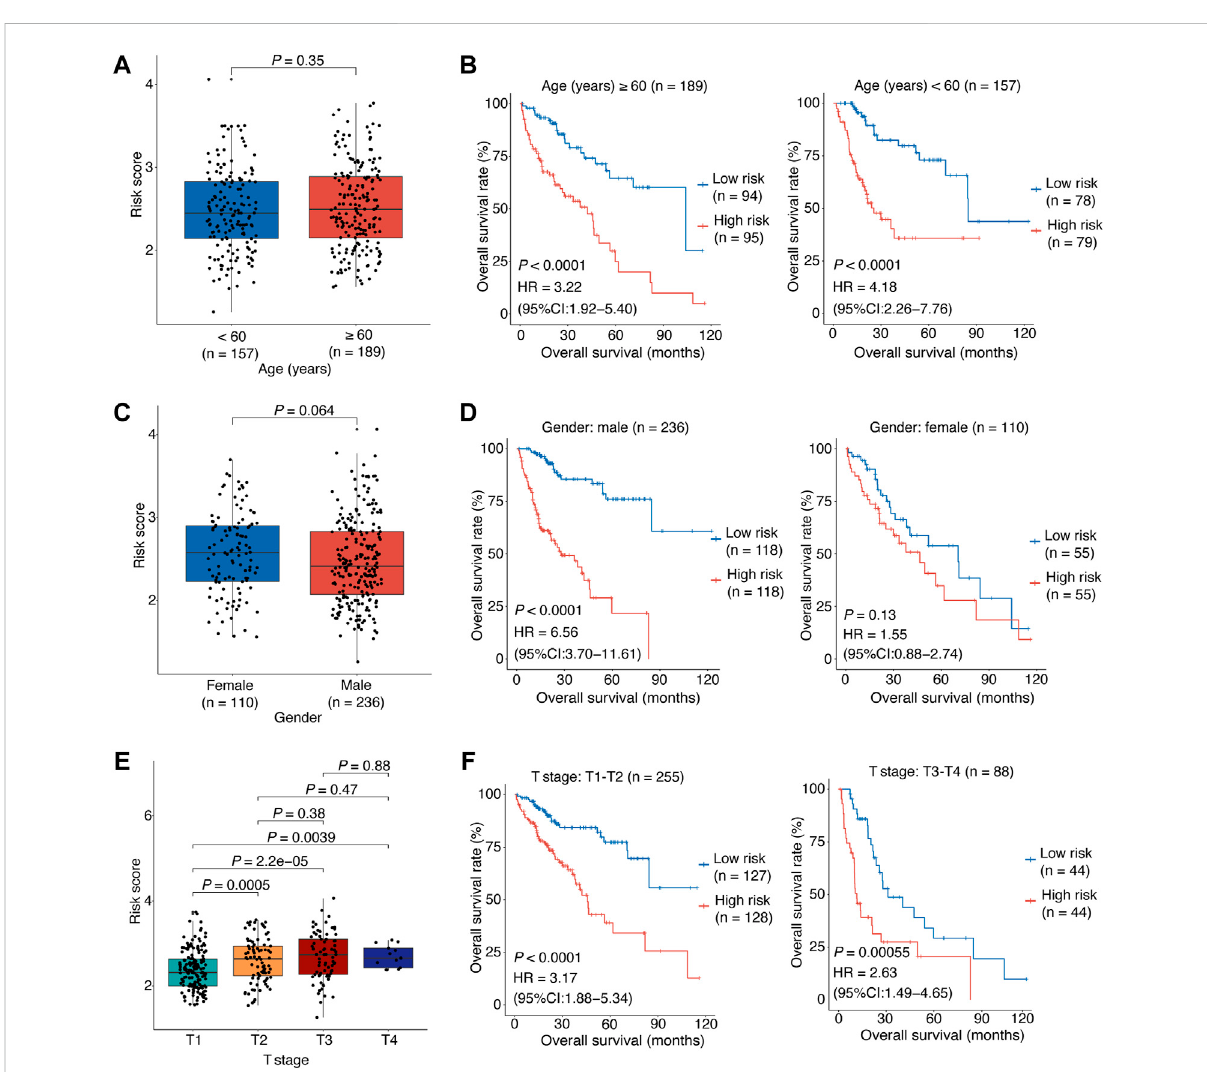
FIGURE 4 Strati fi ed analyses of association between the risk score and HCC overall survival. (A) The correlation between the risk score and the patient ’ s age. (B) The risk score ’ s predictive value in HCC patients strati fi ed by age ( ≥ 60 vs. < 60 years). (C) The correlation between the risk score and the patient ’ sgender. (D) Theriskscore ’ spredictivevalueinHCCpatientsstrati fi edbygender(malevs.female). (E) Thecorrelationbetweentheriskscore and the patient ’ s clinical stage. (F) The risk score ’ s predictive value in HCC patients strati fi ed by clinical stage (T1-T2 vs. T3-T4). In (A – E) , the p values were determined by Wilcox test. In (B – F) , the patients were strati fi ed by the median of the risk scores for each strati fi ed group to perform Kaplan-MeierOSanalysis;the p valuesweredeterminedbylog-ranktestandtheHRswith95%CIswereobtainedfrommultivariateCoxproportional hazards regression analyses. HCC, hepatocellular carcinoma; HR, hazards ratio; CI, con fi dence interval; OS, overall